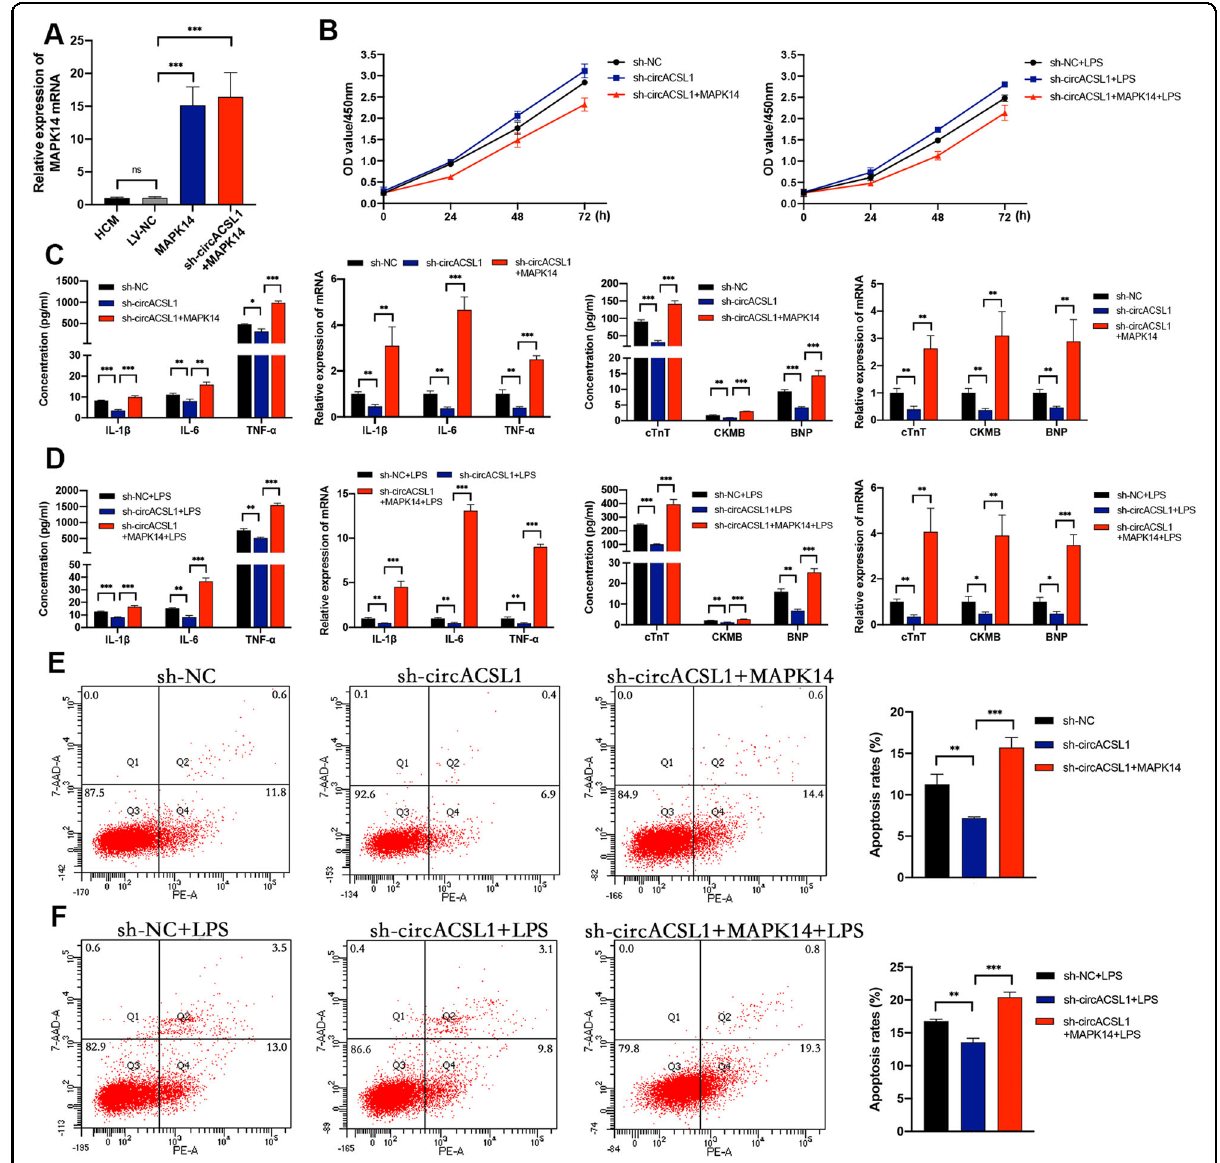
Fig. 7 Overexpression of MAPK14 partly reverses the effects of sh-circACSL1. A – F The circACSL1-knockdown cell lines were co-transfected with MAPK14 overexpression vectors, which were compared with circACSL1-knockdown cells alone. A The overexpression ef fi ciency of MAPK14 was detected by qRT-PCR. B Overexpression of MAPK14 abolished the suppressive effects of sh-circACSL1 on HCM cell proliferation. C , D Sh-circACSL1- induced downregulation of IL-1 β , IL-6, TNF- α , cTnT, CKMB, and BNP were rescued by co-transfection with MAPK14 overexpression vectors and sh- circACSL1. E , F Sh-circACSL1-induced decrease of cell apoptosis was reversed by co-transfection with MAPK14 overexpression vectors and sh- circACSL1. Data are presented as mean ±SD ( n = 3 biologically independent samples). * p < 0.05; ** p < 0.01; *** p < 0.001 (Student ’ s t